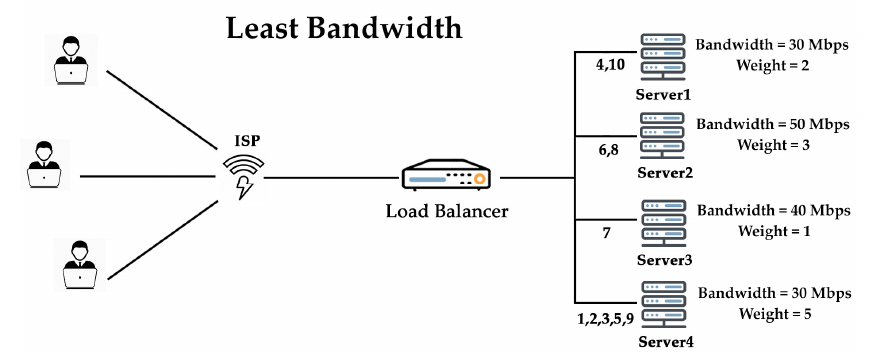
Table 1. The summarized features, advantage, disadvantage and differences of the different load balancing